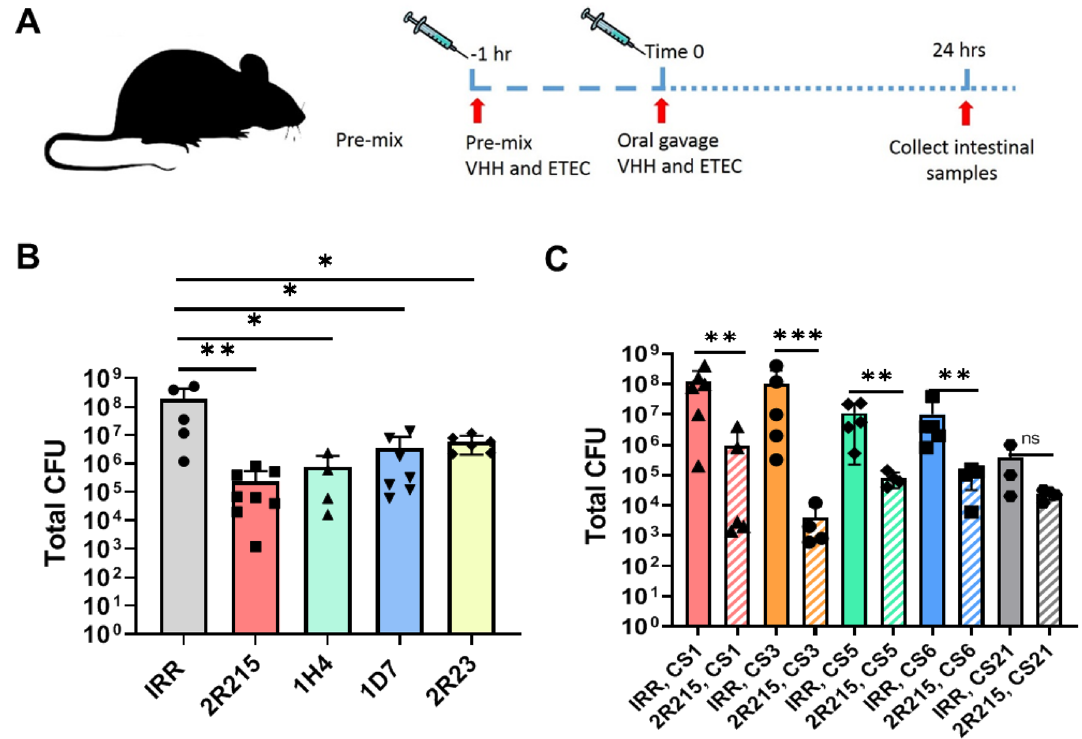
Figure 3. Anti-CfaE VHH prevent ETEC colonization in the small intestine of a mouse model. ( A ) Cartoon representation of mouse colonization experiment. VHH are pre-incubated with 10 7 colony forming units (CFU) of ETEC 1 h prior to intragastric challenge. Animals are euthanized 24 h after challenge, and bacterial colonies in the small intestine are counted. ( B ) DBA/2 mice were challenged intragastrically with 10 7 CFU of H10407 pre-incubated with 100 mg/kg of VHH. For 2R23 50 mg/kg of VHH was used due to lower production yields. At least 5 animals were tested for each condition. Results for all VHH were significantly different from those for the irrelevant VHH ( P < 0.01 for 2R215 and P < 0.05 for 2R23, 1D7 and 1H4). Two biological replicates were performed. ( C ) DBA/2 mice were challenged intragastrically with 10 7 CFU of strains expressing adhesins CS1, CS3, CS5, CS6, and CS21 pre-incubated with 100 mg/ml of 2R215. Treatment with 2R215 resulted in significant reduction of CFUs against ETEC strains expressing CS1 (2.1 log, P < 0.01), CS3 (4.4 log, P < 0.001), CS5 (2.2 log, P < 0.01) and CS6 (2 log, P < 0.01), but not the strain expressing CS21 (1.2 log, P > 0.05). Two biological replicates were performed for strain expressing CS1 adhesin. One biological replicate was performed for all other